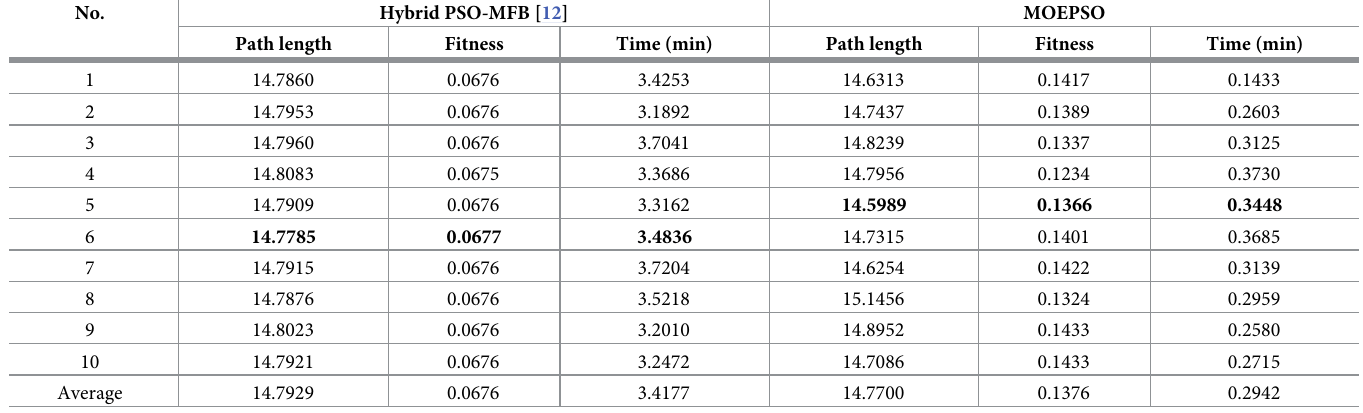
Table 8. Path planning results in the static environment (5 obstacles) Cont.